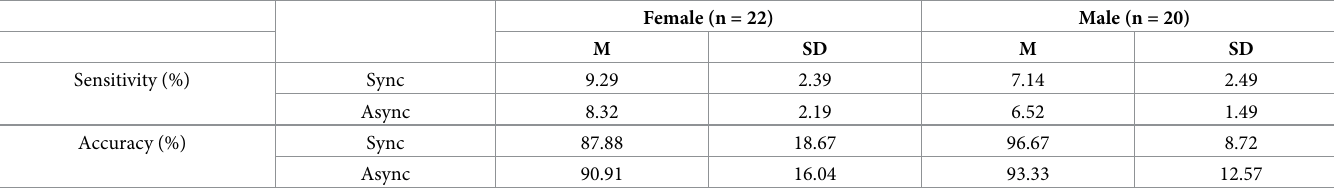
Table 3. Results from analysis of the body changes.